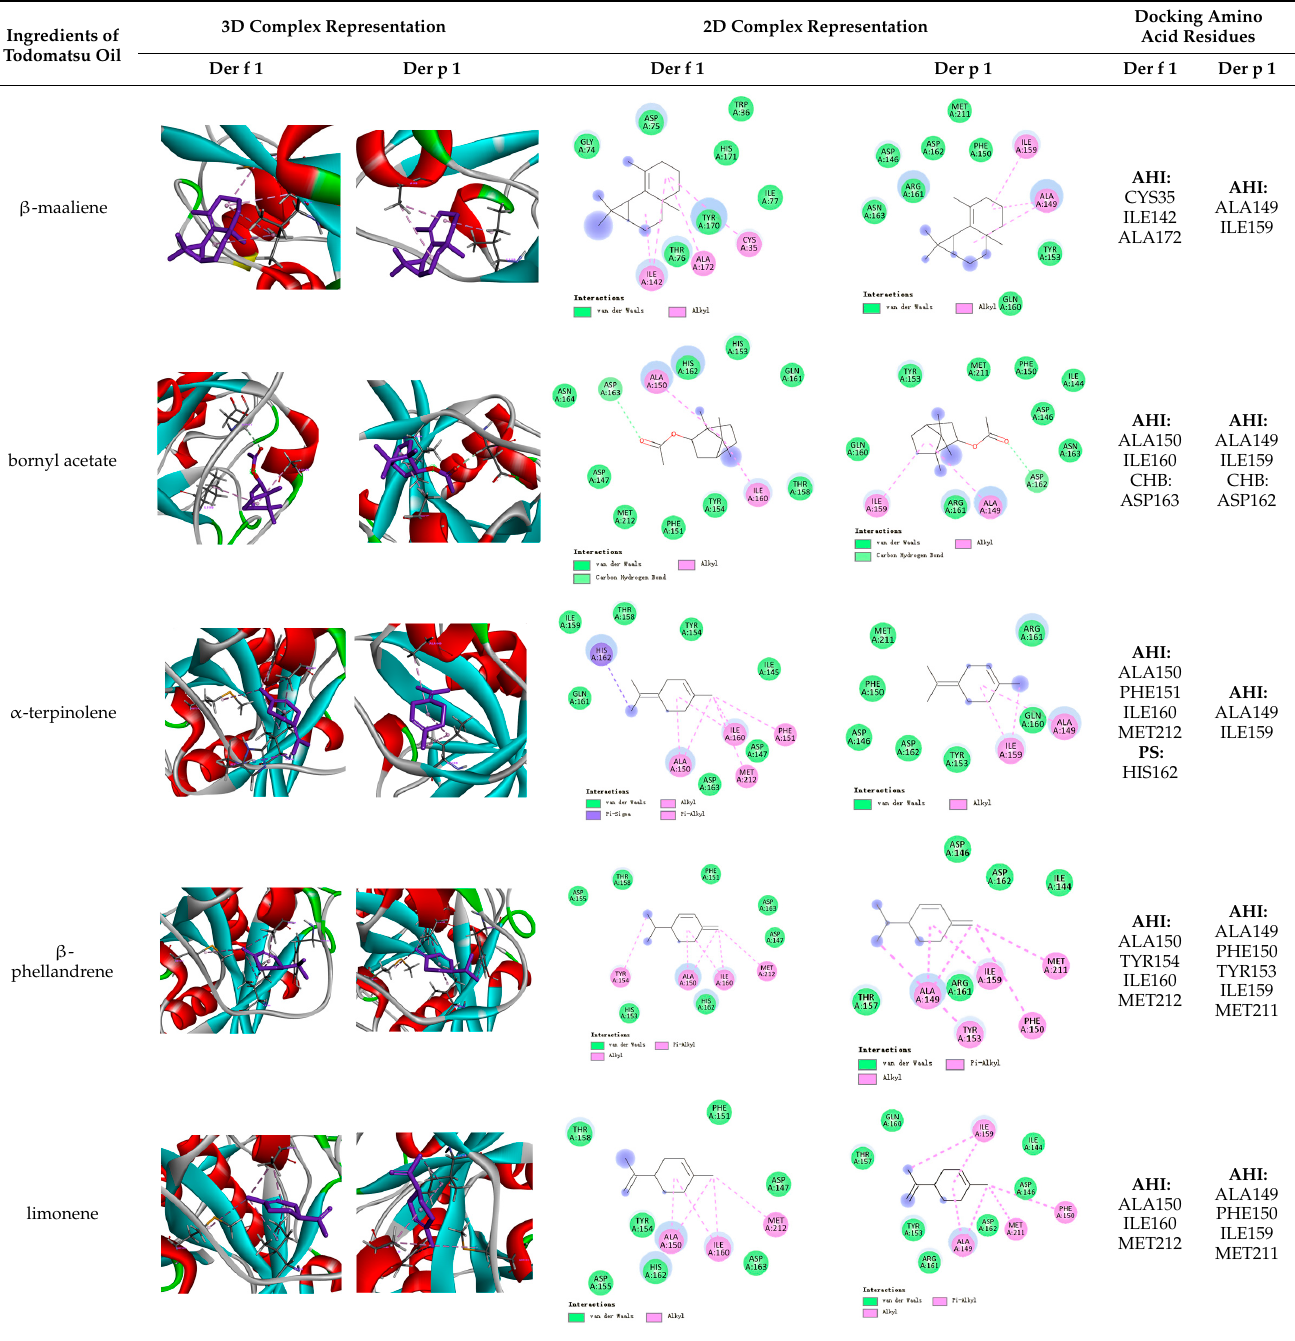
Table 3. 2D and 3D diagrams of top 5 ingredients of todomatsu oil on allergens Der f 1(5vpk)/Der p 1(5vph) binding pocket.